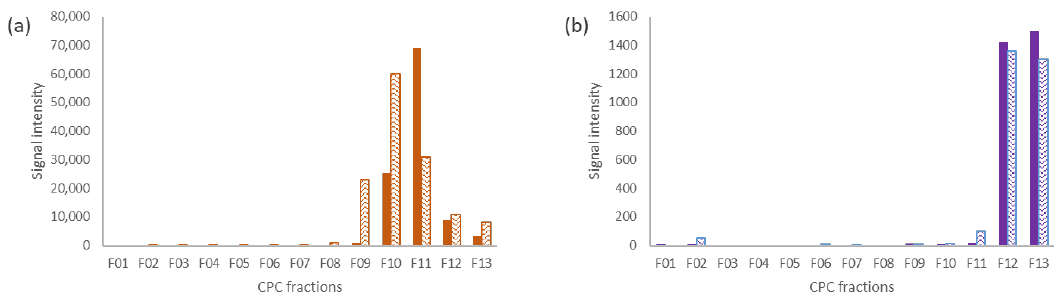
Figure 7. LC-MS elution profiles of ( a ) citric acid and ( b ) proline in dry and glycerin model mixture CPC fractionations. The full boxes correspond to the area of the signal in the fractionation of the dry extract and the hatched boxes to the fractionation of the glycerin extract.